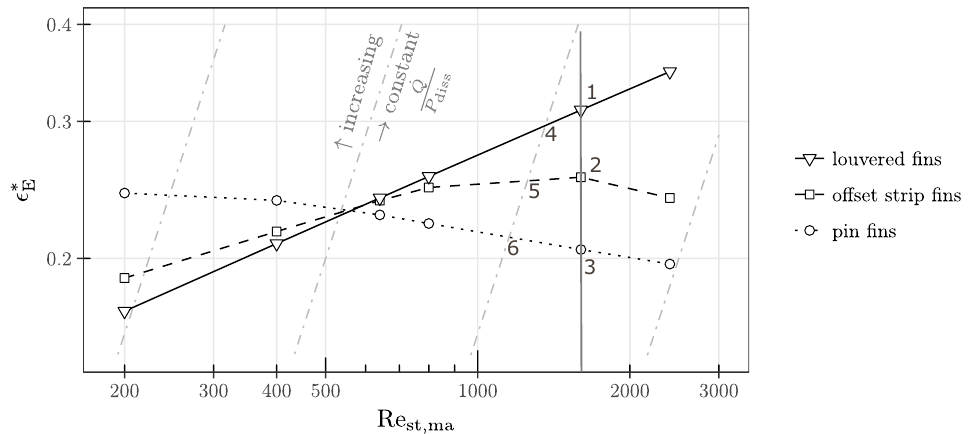
Figure 5. Non-dimensional energy efficiency (cid:101) ∗ versus Reynolds number Re st,ma for different E enhancements; standard comparison is at equal Reynolds numbers; grey dash-dot lines represent combinations of (cid:101) ∗ and Re st,ma with equal ˙ Q / P diss E